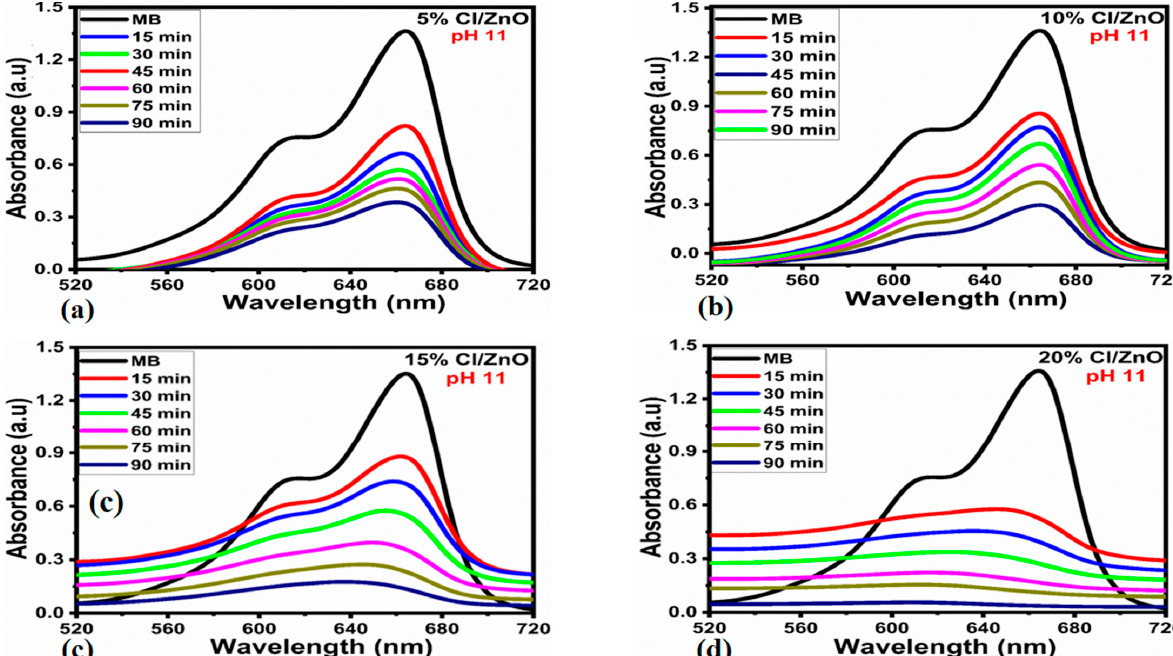
Figure 7. ( a – d ) UV–Vis absorbance spectra monitoring the concentration of MB after 15 min intervals of time for 5%, 10%, 15% and 20% Cl − -doped ZnO at pH 11, respectively. The photocatalytic degradation activity may also be affected by various factors such as the amount of catalysts, the pH value and concentration of MB, the radiation of energy and the irradiation time. The effect of the concentration of Cl − as a dopant into ZnO on the photodegradation of MB dye was investigated using different samples of Cl − -doped ZnO photocatalysts. For this study, the percentage of Cl − as a dopant was varied from 5% to 20% of ZnO to optimize the performance of the photocatalysts. The 0.1 mM concentration of MB dye was kept constant for all samples to evaluate the effect of dopant concentration on the degradation process. The obtained data reveal that the photocatalytic degradation efficiency for MB with pristine ZnO was about 57.75% and 75.78% over 200 min at pH of 5 and 11, respectively, as shown in Figure 8a. The performance with 5%, 10%, 15% and 20% Cl − -doped ZnO over a period of 90 min was calculated to be 64.47%, 71.35%, 80.03% and 89.91%, respectively, at pH 5 (see Figure 8b). These values are markedly enhanced upon increasing the pH to 11, where under the same reaction time (90 min), degradation efficiencies of about 75.20%, 81.19%, 88.67% and 99.45% were achieved, as shown in Fig- ure 8c. In view of these results, it is established that with a 20% Cl − concentration in ZnO, the best photocatalytic activity was attained for MB degradation with efficiency levels of ∼ 89.91% and 99.47% within 90 min at pH values of 5 and 11, respectively, as represented in Figure 9b,c. This improved photocatalytic performance with 20% Cl − dopant ZnO could be attributed to the presence of surface-active sites and a reduction in the optical band gap [55]. Thus, it can be concluded that 20% Cl − -doped ZnO gives the maximum degradation efficiency and hence may be considered as a promising photocatalyst for wastewater treat- ment. It is widely accepted that the pH of a stock solution can be considered as a main factor and plays a vital role in driving the photosensitivity of a material through the surface charges [56,57]. For this purpose, we studied the effect of pH on the photosensitivity of as-prepared Cl — -doped ZnO materials towards the degradation of MB at pH 5 and 11. The pH value was set with the help of 0.1 M HCl and 0.1 M NaOH. The MB concentration of 0.1 mM was kept constant. In this study, we found that the photocatalytic efficiency of